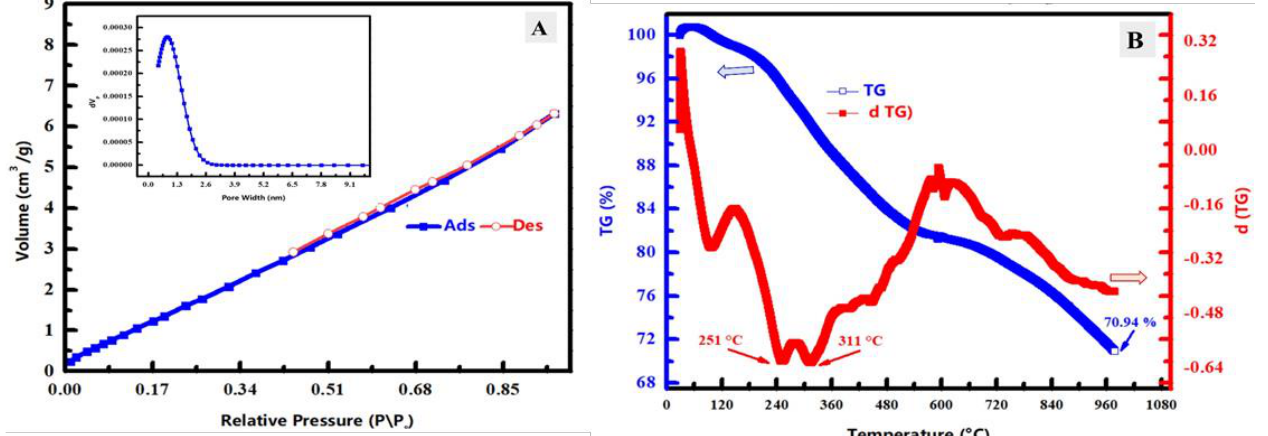
Figure 5. ( A ) Nitrogen adsorption–desorption analysis of the prepared ZnTiO@PANi composite including the pore width analysis in the inset of the figure. ( B ) TGA and DTG analysis of the prepared ZnTiO@PANi composite.